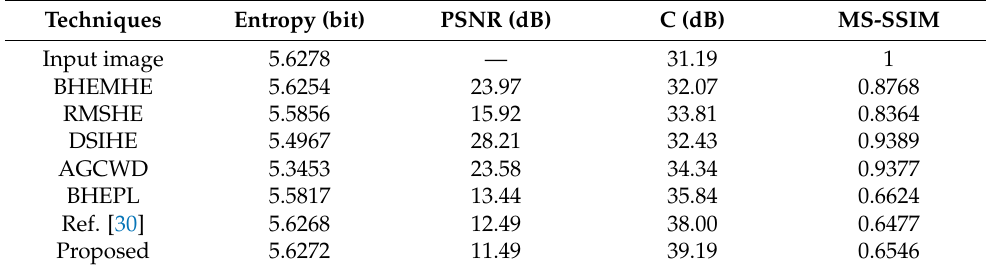
Table 2. Experimental data for the low-grayscale image “Tractor”.